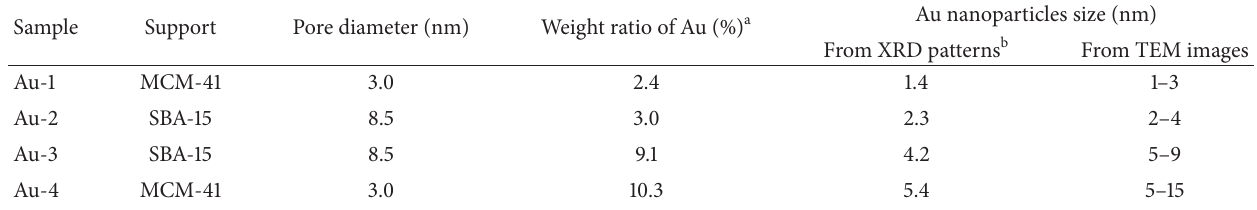
Table 1: Structural parameters and supported Au nanoparticles size on mesoporous silica with different amounts of Au loading.